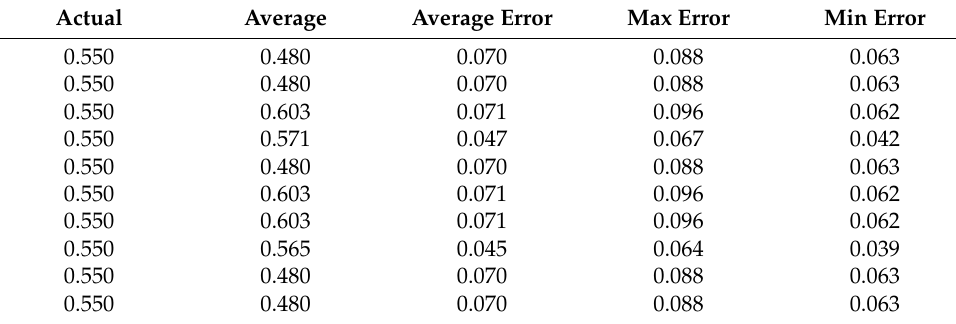
Table A219. Set 3, trials 41–50 data (all 0.5 PR